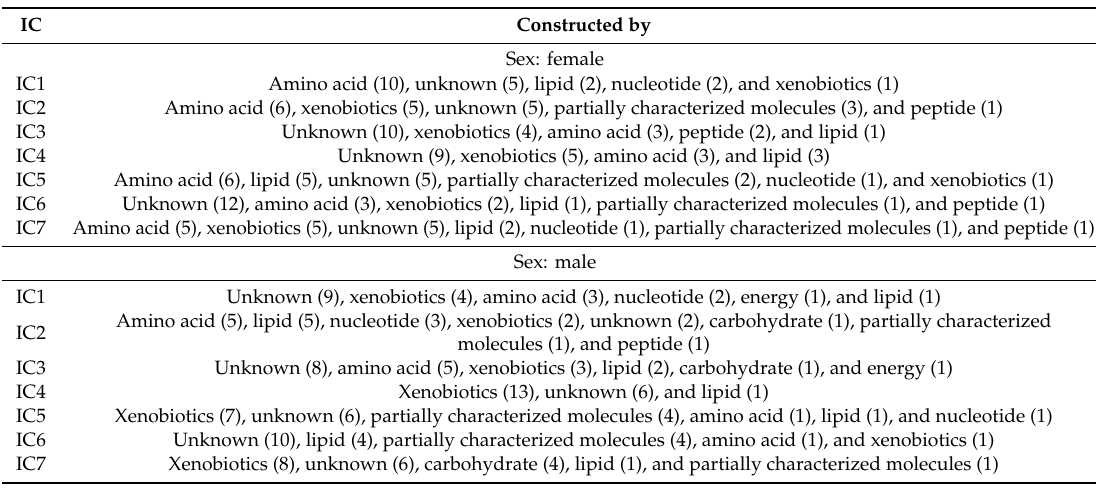
Table A1. Names of the Independent